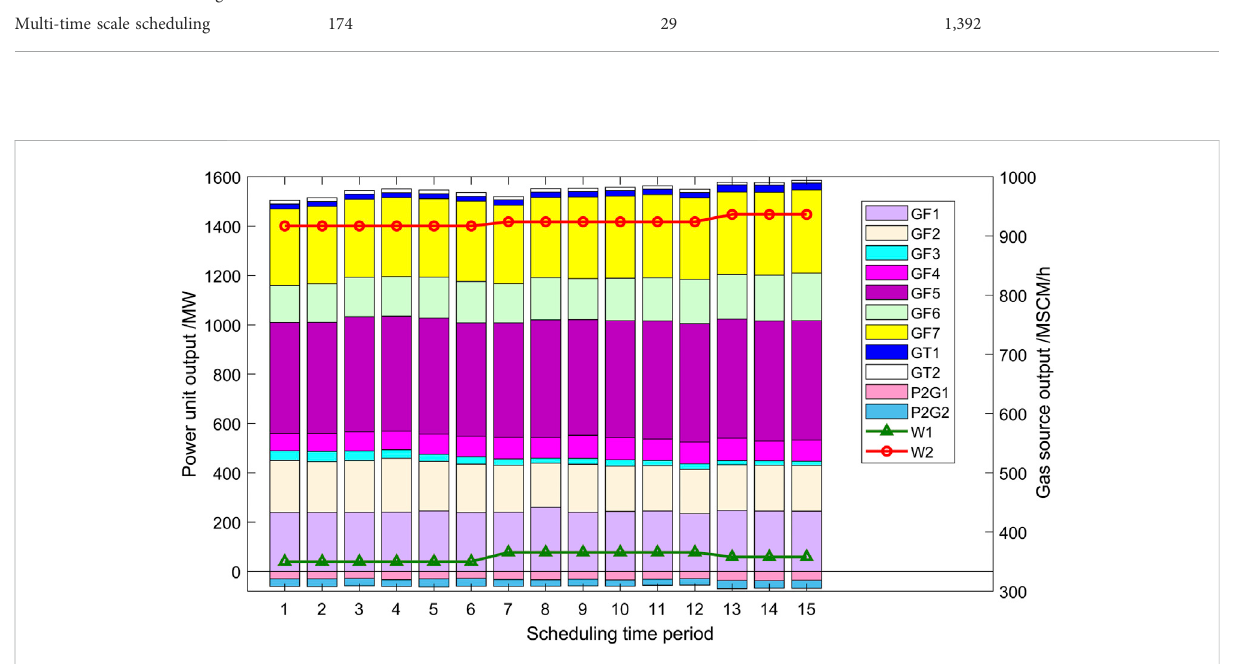
FIGURE 14 The output of each control quantity changes with